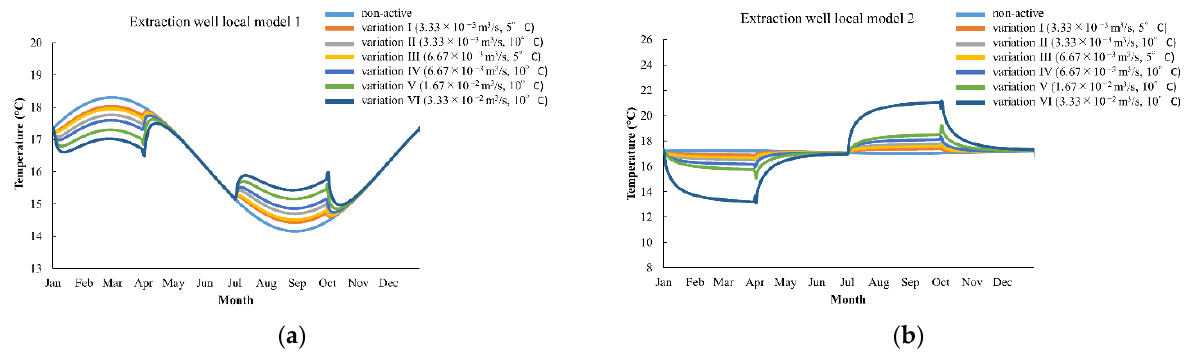
Figure 17. Groundwater temperature at extraction well on local models 1 (a) and local model 2 (b).